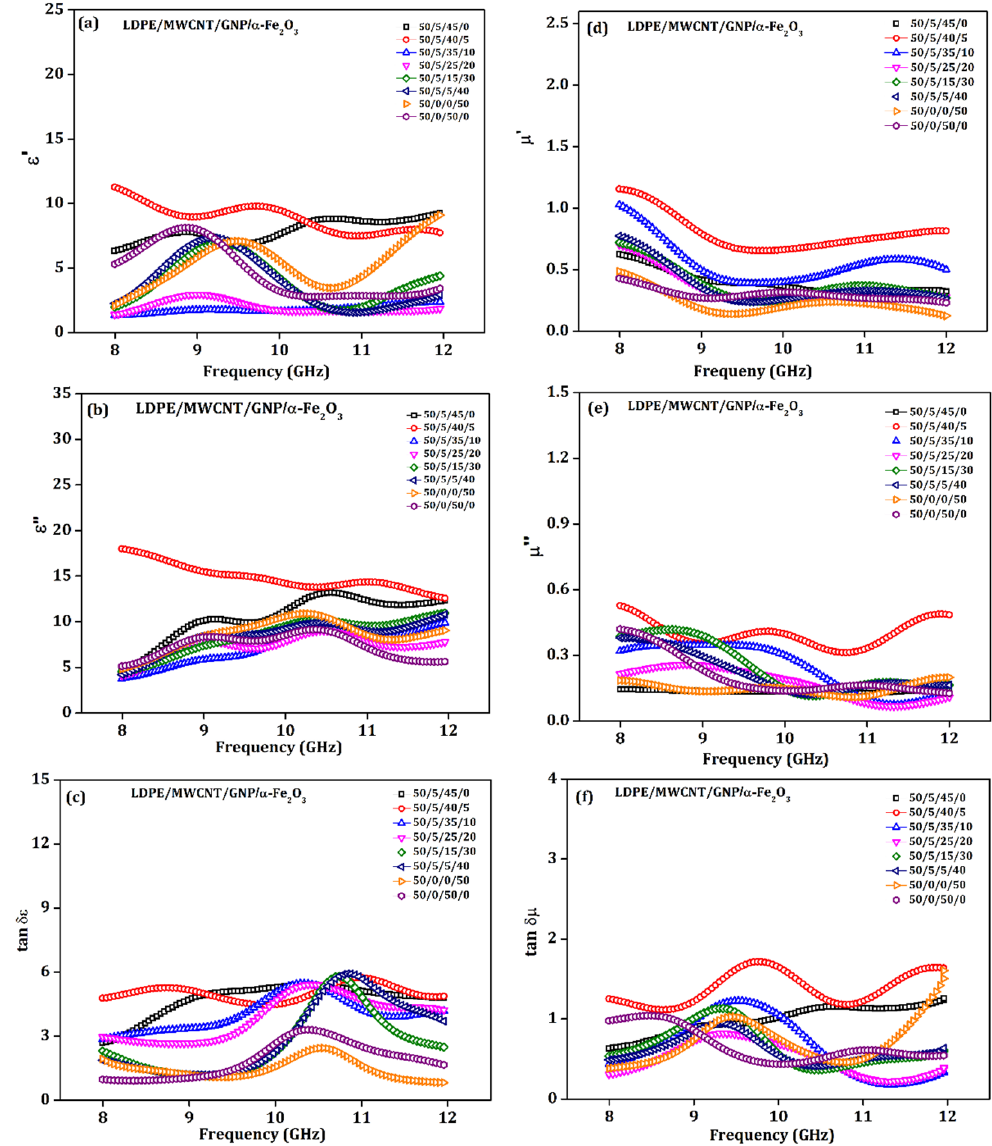
Figure 9. ( a ) real permittivity ( ε (cid:48) ) , ( b ) imaginary permittivity ( ε (cid:48)(cid:48) ) , ( c ) tan δε , ( d ) real permeability ( µ (cid:48) ) , ( e ) imaginary permeability ( µ (cid:48)(cid:48) ) , and ( f ) tan δµ as a function of frequency. The reasonably elevated ε (cid:48) indicates the availability of polarons and bi-polarons